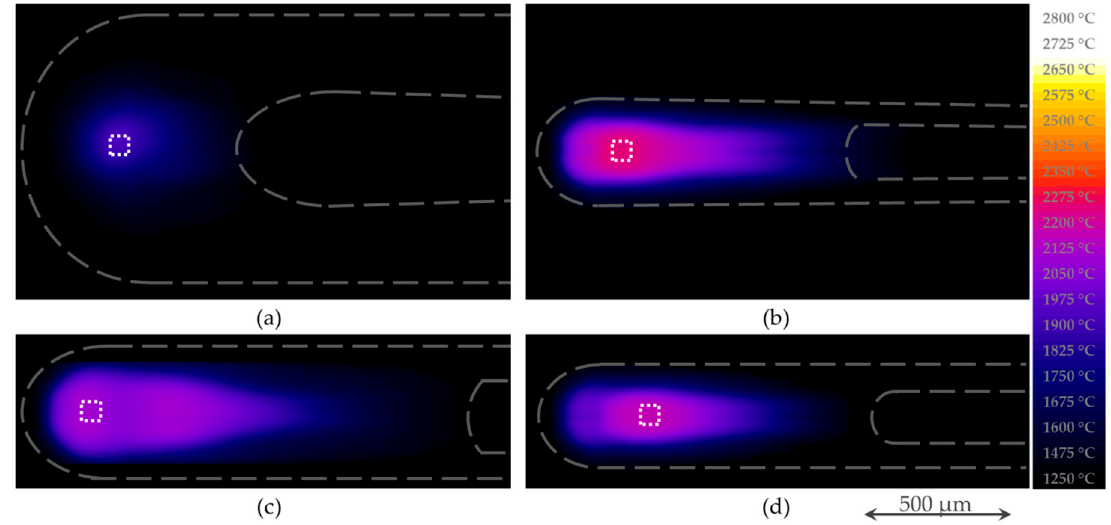
Figure 15. Distribution of average temperature T i , j calculated with e = 1 from all single images within the complete measurement period of 500 ms of 12 mm stainless steel cut with the following parameters: ( a ) Set #1: Static beam shaping; and different values of the longitudinal, linear beam oscillation parameters: ( b ) Set #2: 300 µm amplitude and 500 Hz frequency; ( c ) Set #3: 550 µm amplitude and 500 Hz frequency; ( d ) Set #4: 300 µm amplitude and 2000 Hz frequency; the square marks the submatrix T p,p ( t ) positioned at the highest average temperature.